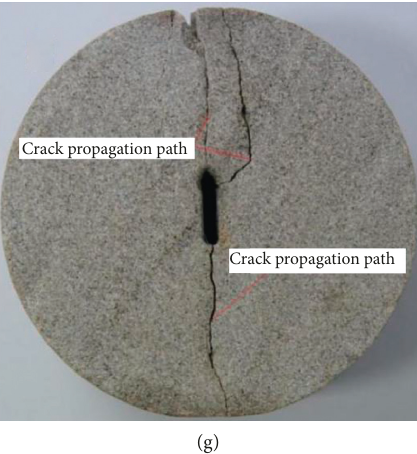
0; (b) β 15 ° ; (cid:31) (cid:31)